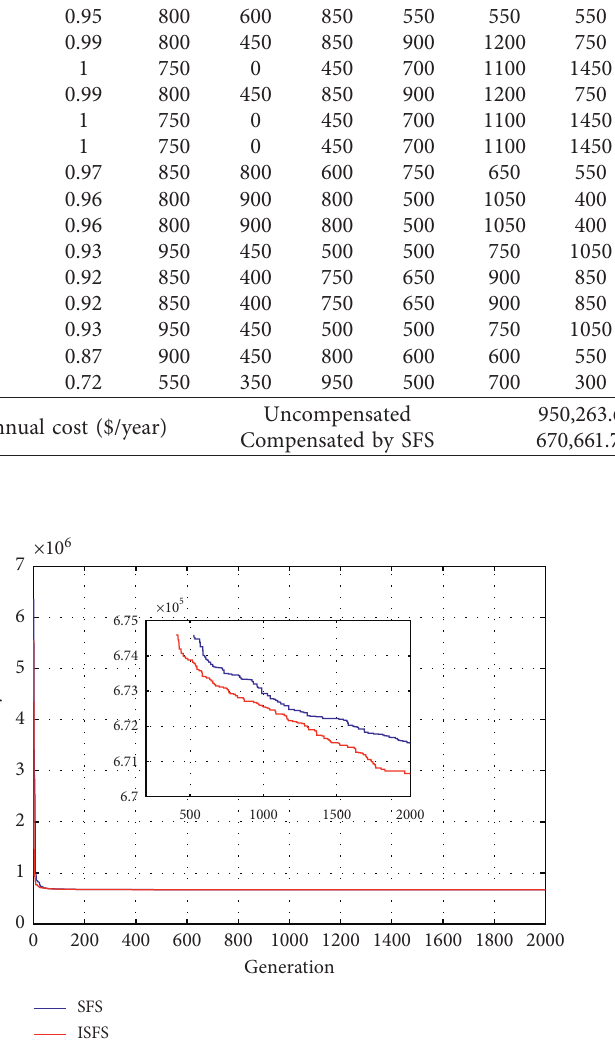
Figure 21: Convergence characteristics of annual cost for 119-bus network in scenario